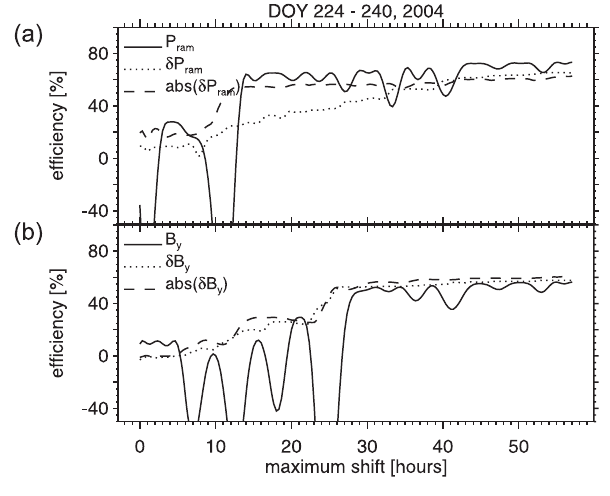
Fig. 5. In (a) the efficiency functions for the magnetic compo- nents B x and B z and the efficiency function for the time derivative of the SW proton temperature δT p are displayed. Part (b) shows the efficiency functions for the Akasofu-parameter ε , the modified Akasofu-parameter ε mod , the reconnection voltage 8 and the KH- instability quantity Q